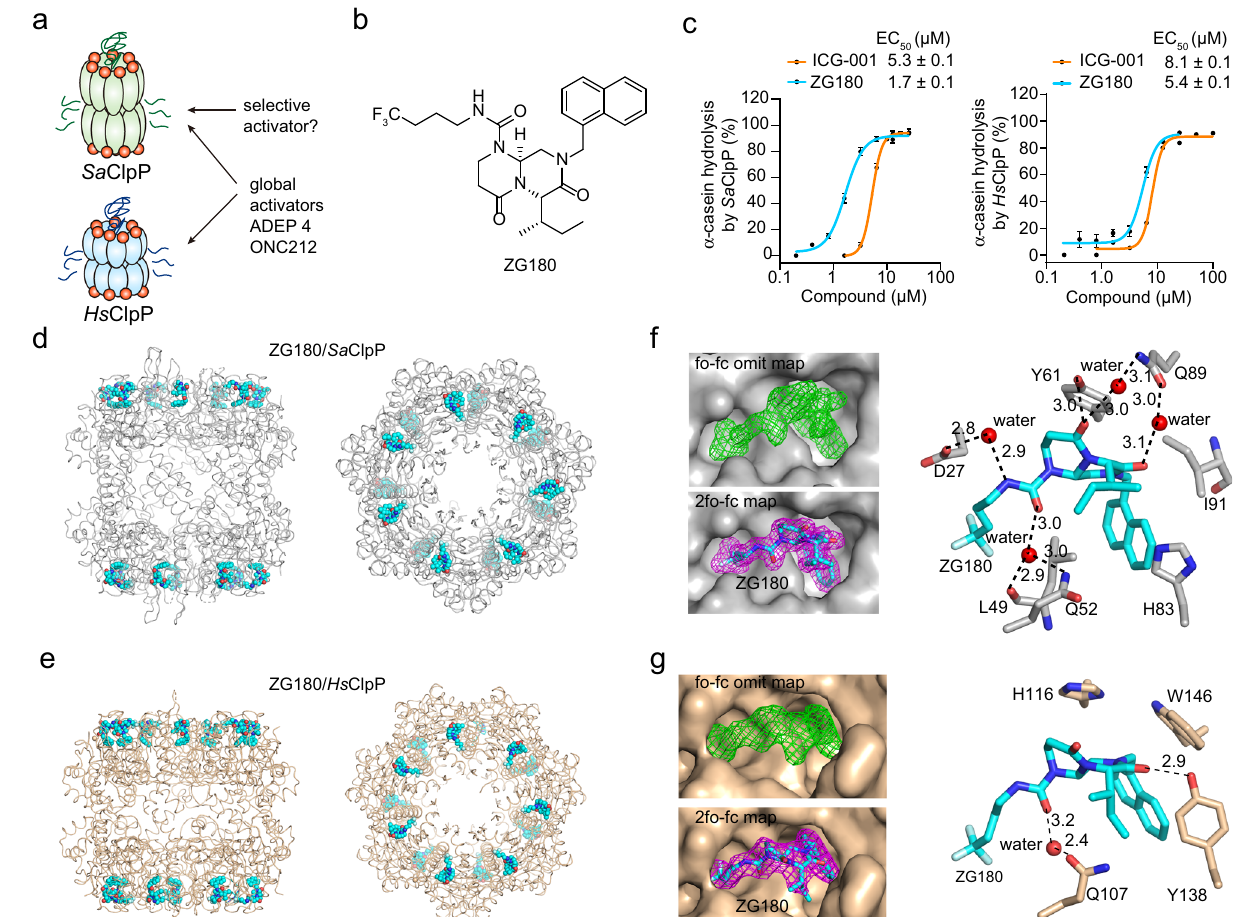
Fig.1|Identi fi cationofZG180aspotentClpPactivator.a Thegoalofthisworkis to develop selective Sa ClpP activators. b The synthetic lead compound ZG180 as ClpP activator. c Quantitation of α -casein hydrolysis by Sa ClpP and Hs ClpP in the presence of ICG-001 and ZG180, respectively ( n =3 biologically independent experiments).Data are presentedasmean±SD(error bars).X-ray crystal structure of ZG180/ Sa ClpP ( d ) and ZG180/ Hs ClpP ( e ) complexes. Side and top views of the structuralcomplexesaredisplayed. Sa ClpPisshowningraycartoontube, Hs ClpPis